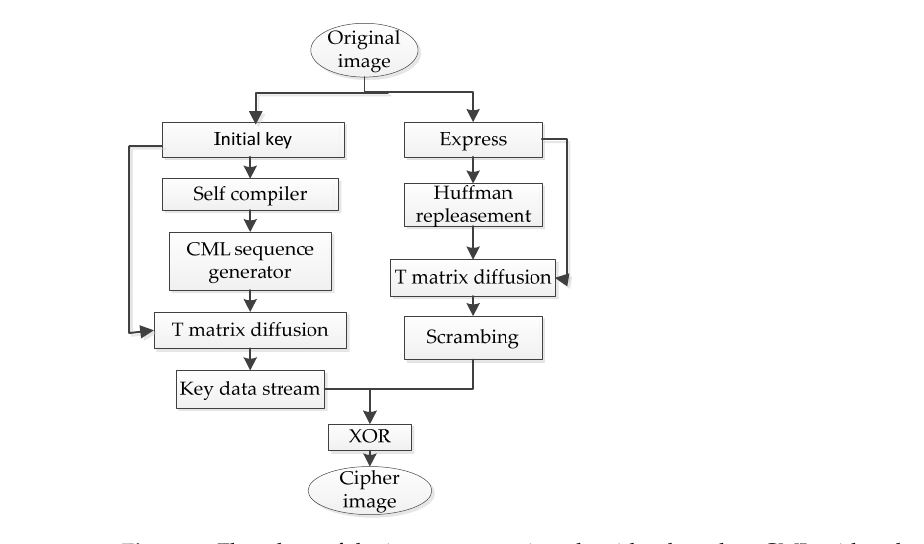
Figure 4. Flowchart of the image encryption algorithm based on CML with polymorphic mapping.